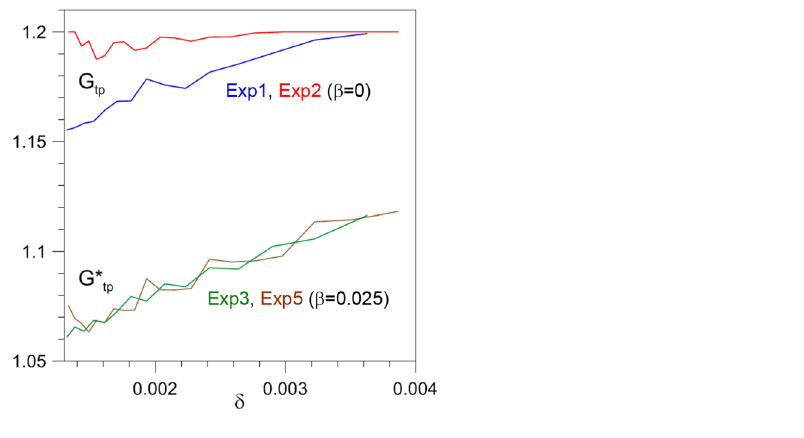
Figure 9. Rate-induced tipping in the presence of periodic perturbations. Same as Fig. 6 but for a limited range of δ -values for the unperturbed (Exp1 and Exp2) and corresponding perturbed (Exp3 and Exp5) cases with β = 0.025 and T = 5